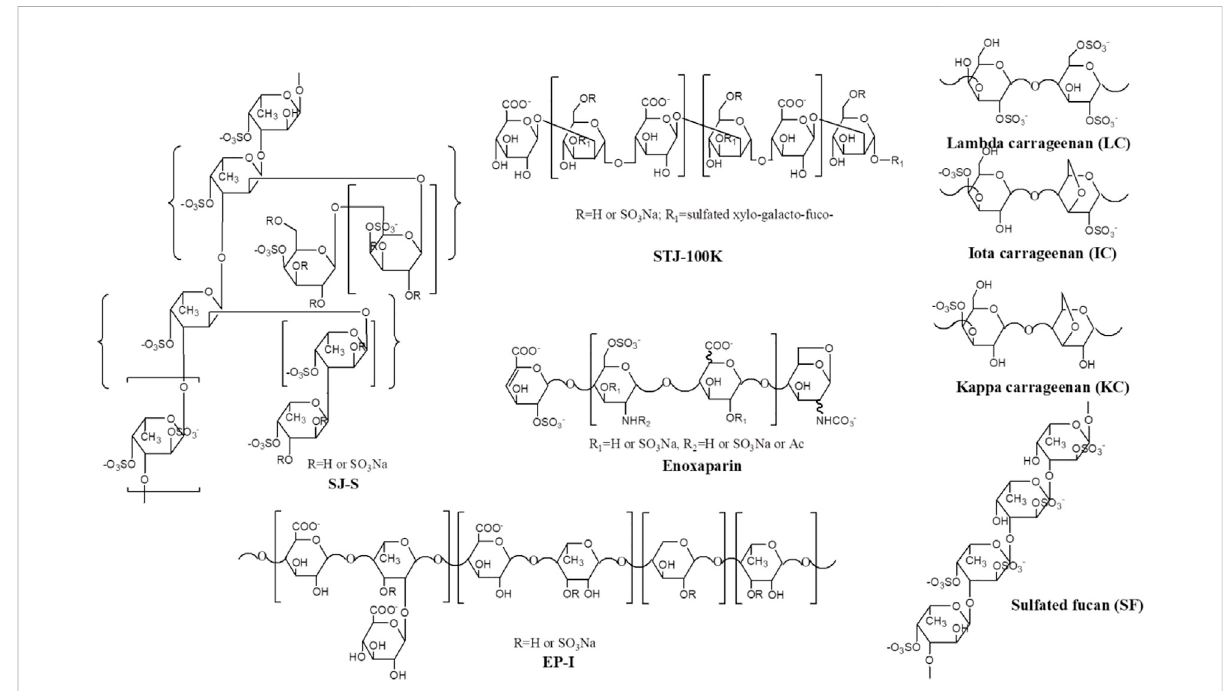
FIGURE 1 Proposed primary structures of polysaccharides used in this study.